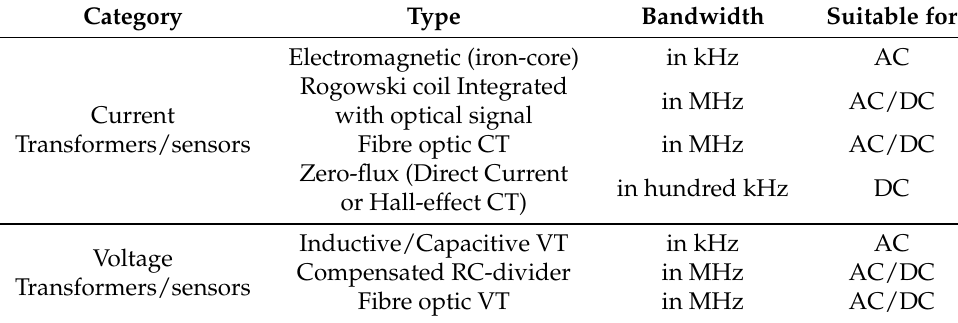
Table 3. Conventional and non-conventional sensors